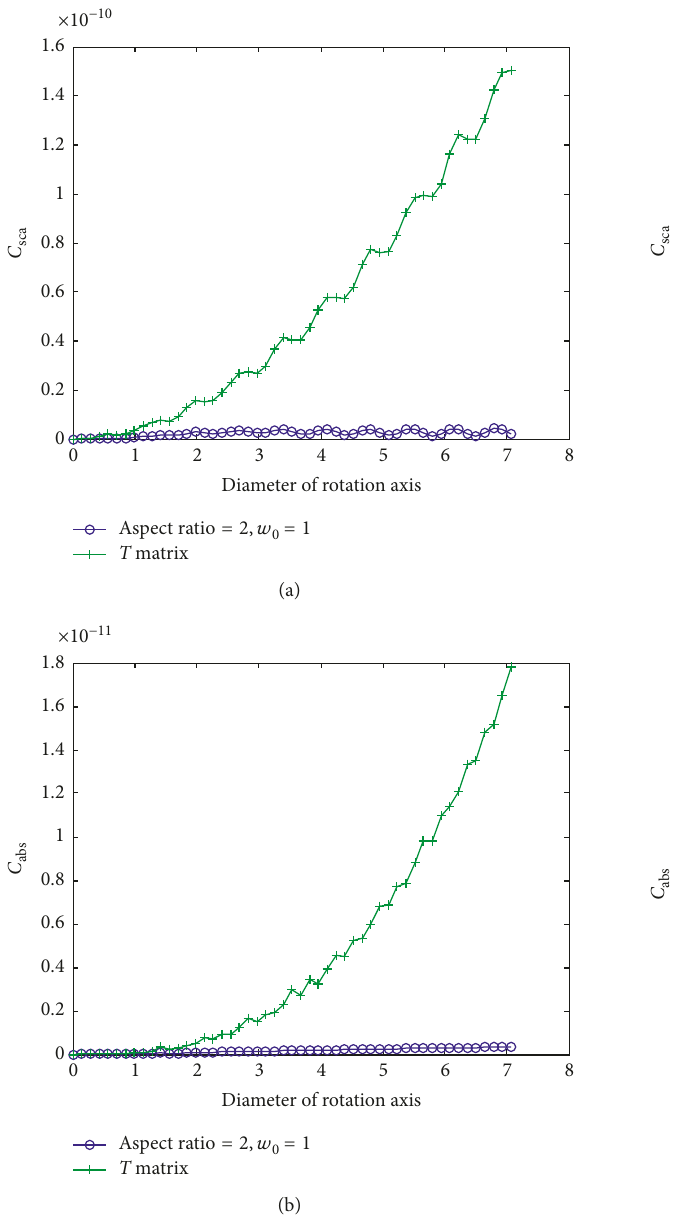
Figure 5: Scattering and absorbing cross sections of feldspar particles (aspect ratio